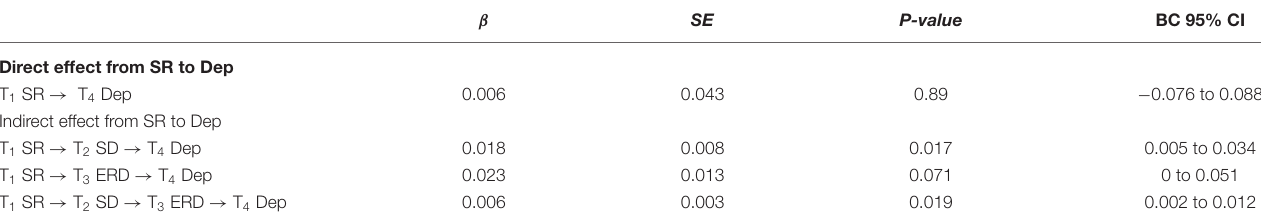
TABLE 3 | Standardized direct and indirect path coefficients from sleep reactivity to depression.